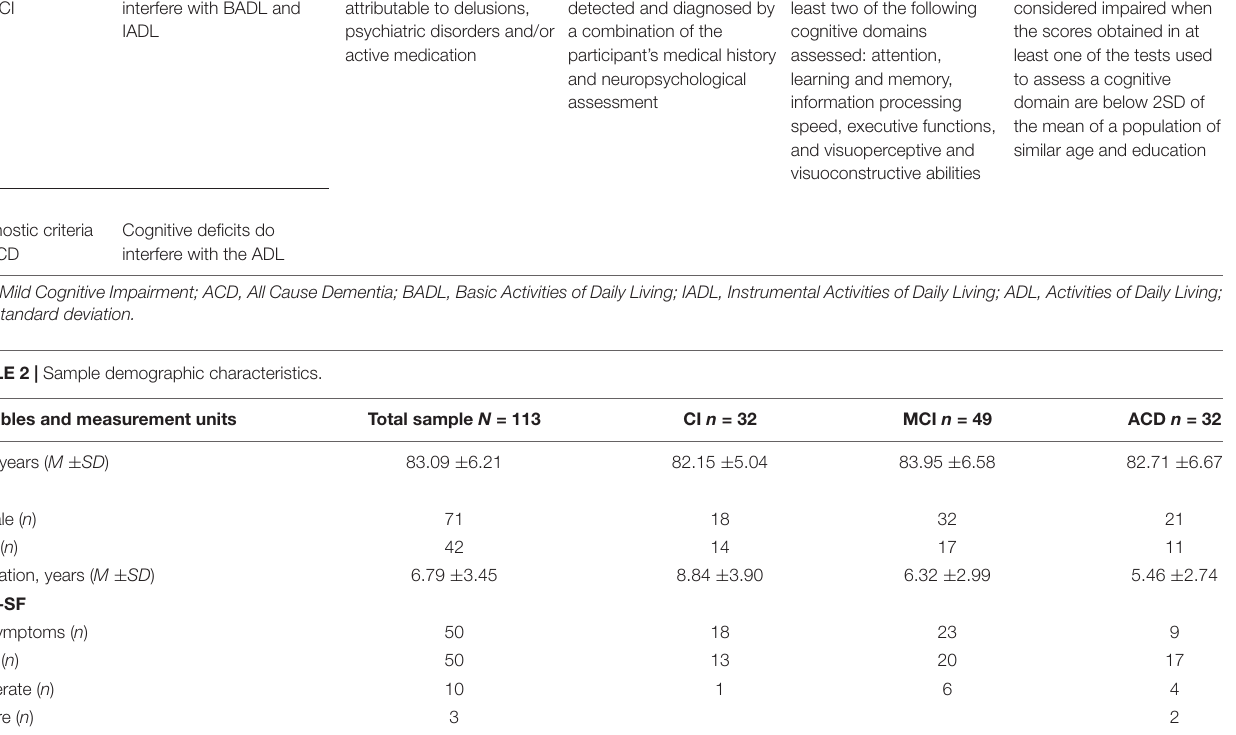
TABLE 1 | Diagnostic criteria (differential: column 1; common: columns 2–5) to classify participants according to their cognitive status. Diagnostic criteria for